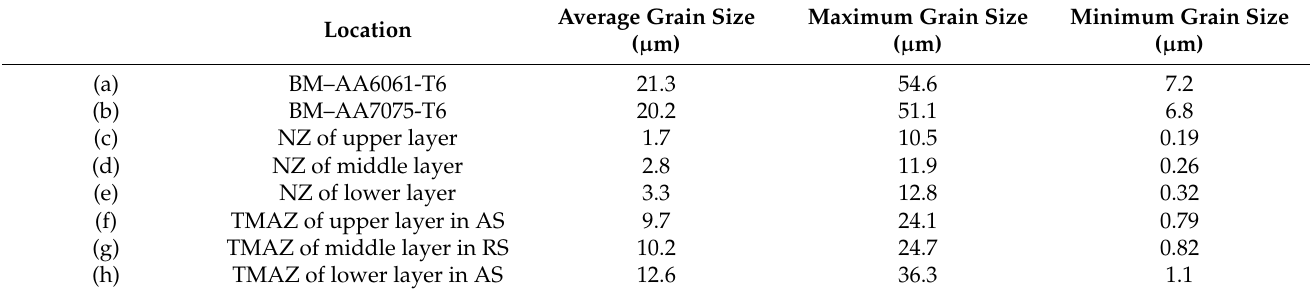
Table 3. Grain size distribution at various